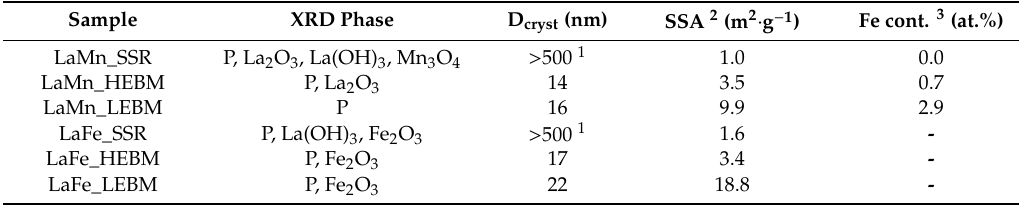
Table 1. Structural, textural properties and elemental composition obtained for LaMnO 3.15 and LaFeO 3 after each synthesis step.